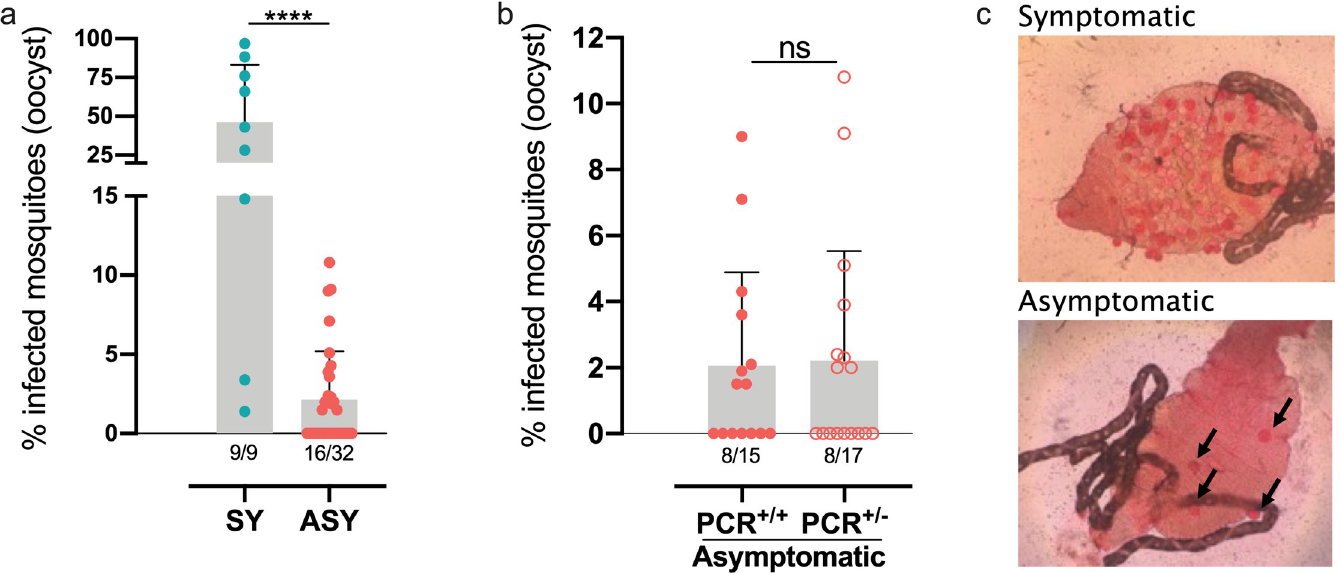
Fig 7. Asymptomatic individuals can infect N . darlingi even with undetectable parasitemia by qPCR. Eighty to one-hundred colony raised females of N . darlingi were fed in fresh blood collected from symptomatic patients (SY) and asymptomatic individuals (ASY), with current (PCR +/+ ) or past (PCR +/- ) detected low parasitemia by qPCR. Each dot represents individual values of the frequency of infected mosquitoes by person. �� p < 0.01. ns- not significant. two-tailed Mann-Whitney U test. c) Photomicrographs showing several oocysts in midguts from mosquitoes fed in symptomatic or asymptomatic individuals (arrows).